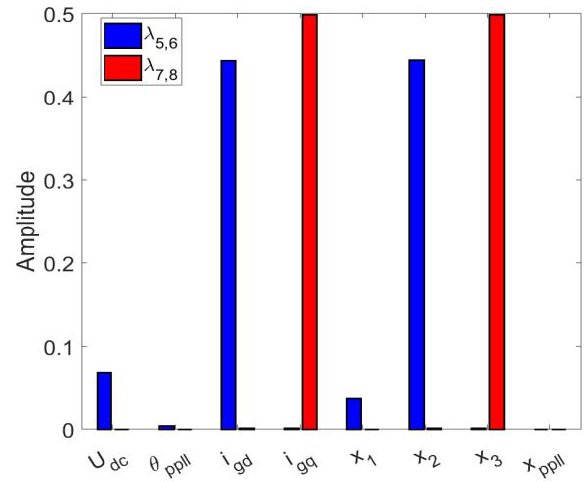
Figure 5. Participation factors of SSR modes with k p 1 = 0.1.